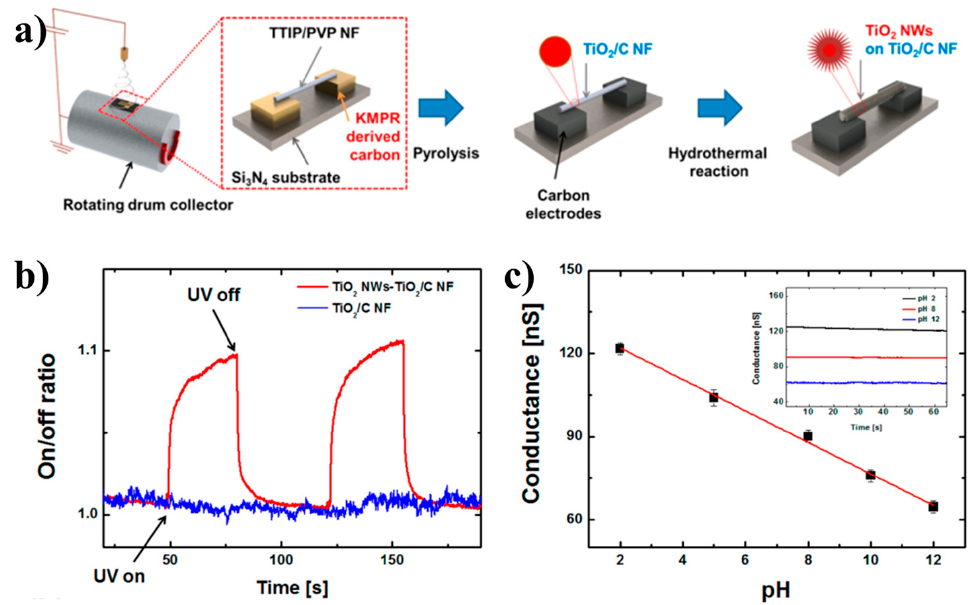
Figure 10. Electrospun NP interfaces for photoelectronic semiconductor sensor: ( a ) Fabrication of hierarchically structured TiO 2 nanowires (TiO 2 NWs) on TiO 2 -carbon (TiO 2 / C) NFs suspended and aligned on carbon electrodes; ( b ) and ( c ) applications of hierarchically structured TiO 2 NWs-TiO 2 / C NF suspended on a carbon-electrode-based electronic device as a ultraviolet (UV) and pH sensor [125], copyright 2014 American Chemical Society.